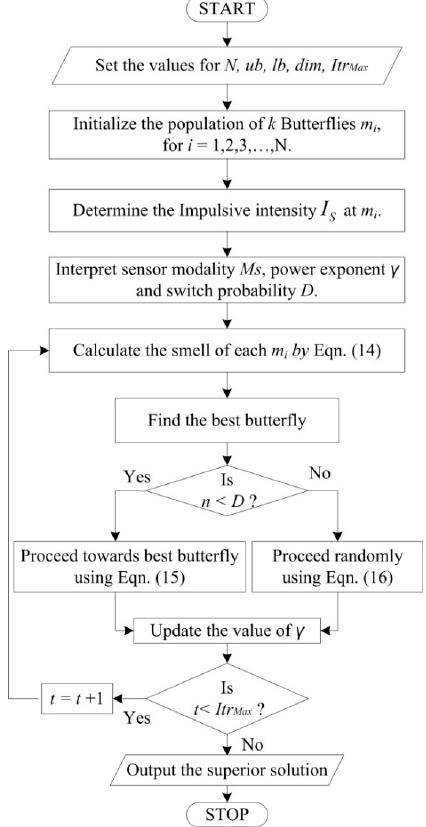
Figure 2. Flow diagram of butterfly optimization technique (BOA).